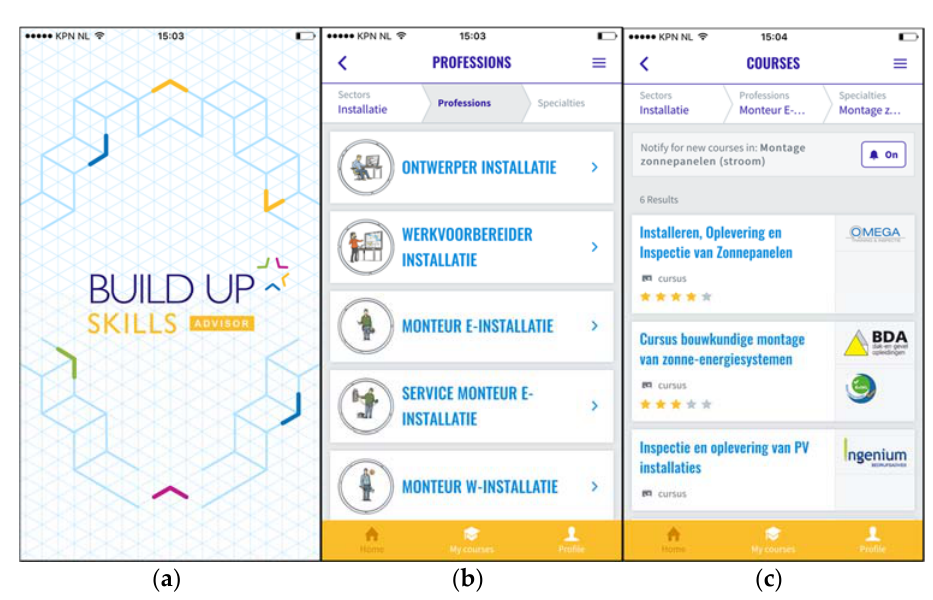
Figure 3. Integration with the BUILD UP Skills advisor app with Dutch content (English content expected at the end of 2017) ( a ) splash screen; ( b ) selection of profession; ( c ) CPD ‐ training supply for the selected profession